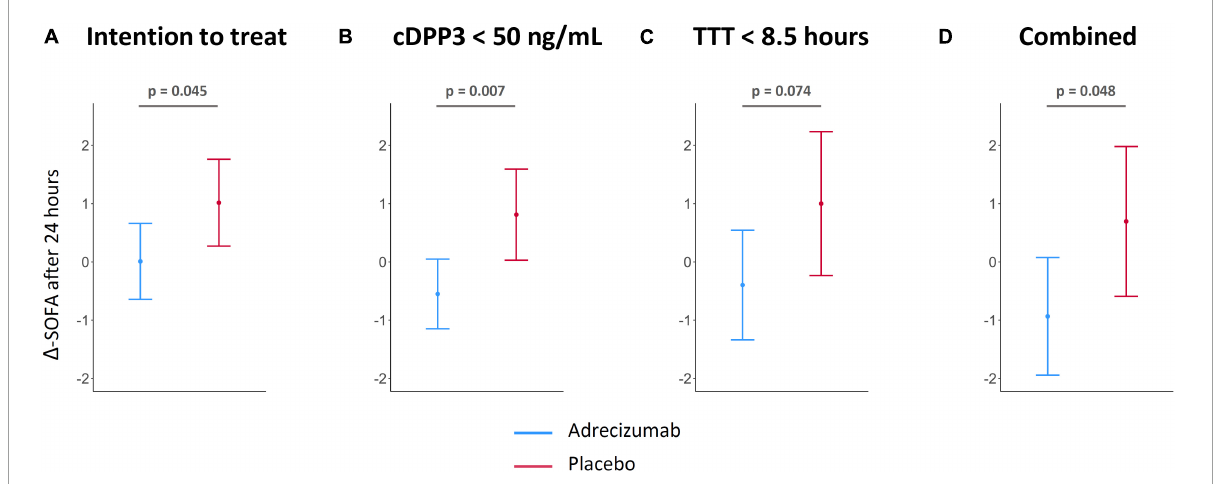
FIGURE5 Change of sequential organ failure assessment (SOFA) score after Adrecizumab/placebo infusion, based on circulating dipeptidyl peptidase 3 (cDPP3) stratification. Data is displayed for the original intention to treat (ITT) analysis (15) (A) , the cDPP3 < 50 ng/mL subgroup (B) , the early treatment ( < 8.5 h) subgroup (C) and the subgroup combining cDPP3 and treatment timing stratification (D) . The SOFA score was determined immediately prior to dosing and 24 h after start of treatment. The difference between the SOFA score pre-dosing and the SOFA score after 24 h of treatment was calculated for each patient, and the means ± 95% CI from the resulting values are represented in the Figure. For patients who died within 24 h of treatment, the SOFA was set to